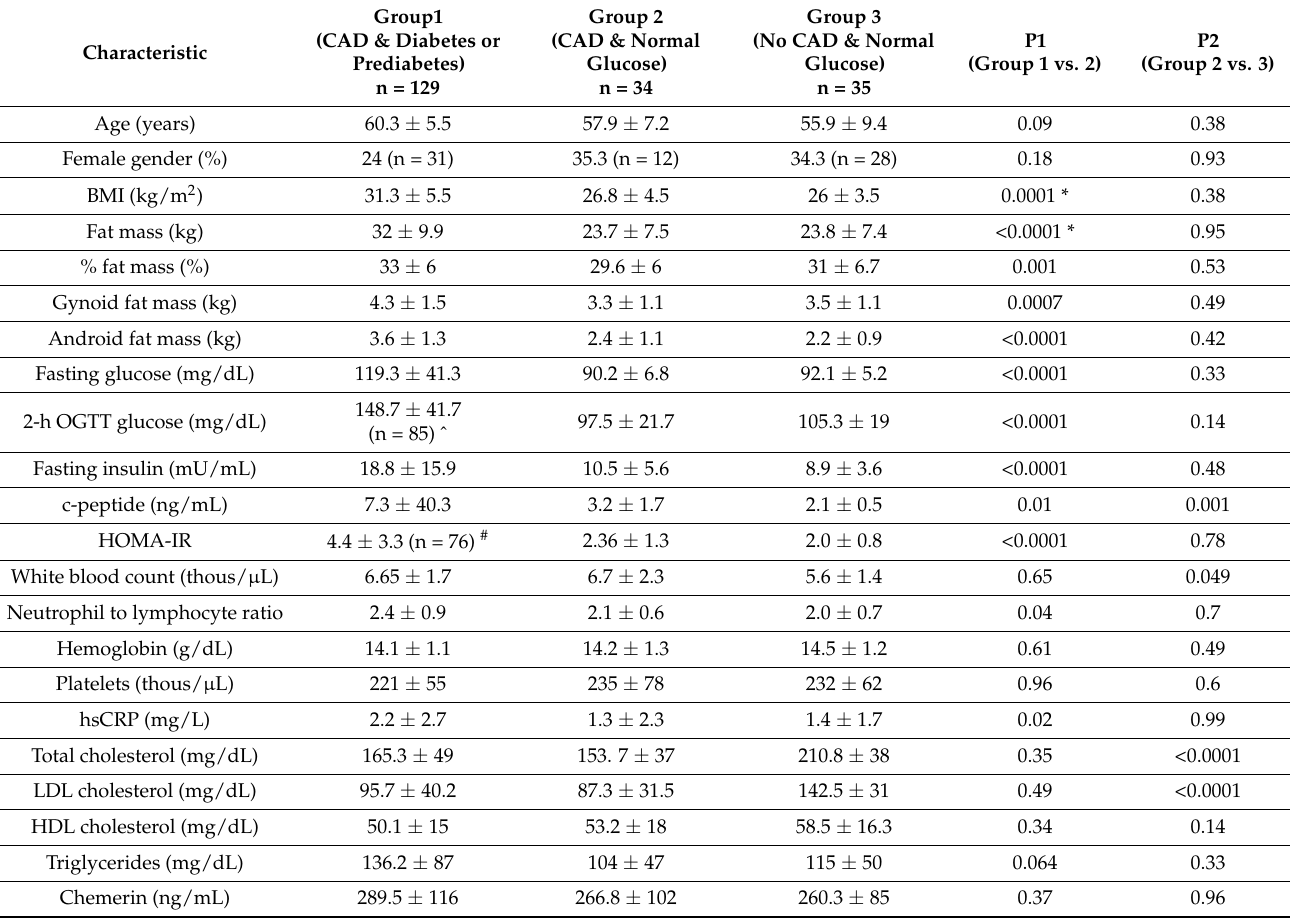
Table 2. Clinical characteristics of the studied